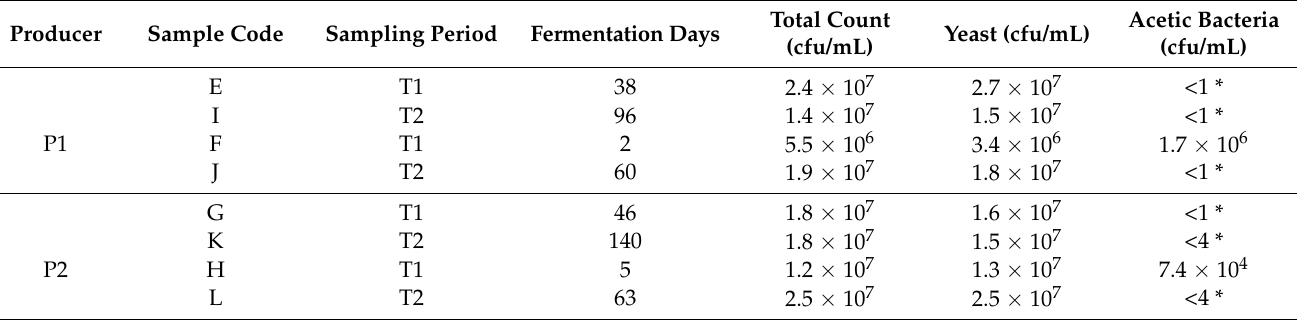
Table 5. Plate-count results (total microorganisms, yeasts, and acetic bacteria) in cfu/mL over fermentation (average of duplicate samples).